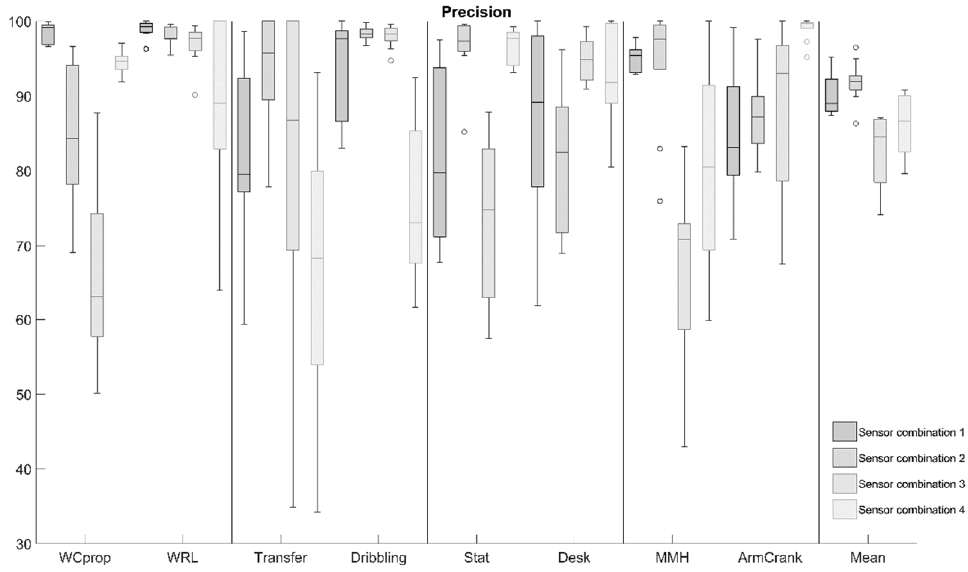
Sensors 2022 , 22 , 7404 10 of 16 Figure 5. The box plots for “precision” of the four sensor combinations, indicating the median, upper, and lower quartiles (the box), minimum and maximum values (error bars) and eventual outliers ( ◦ ).